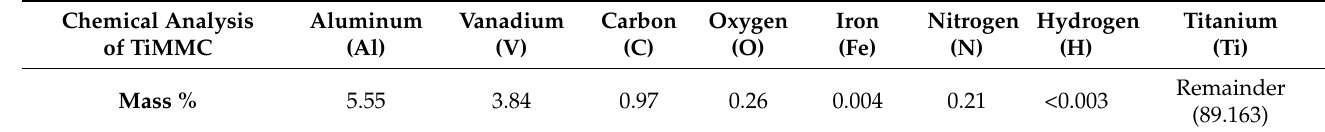
Table 1. Elemental composition of Ti-MMC [32].